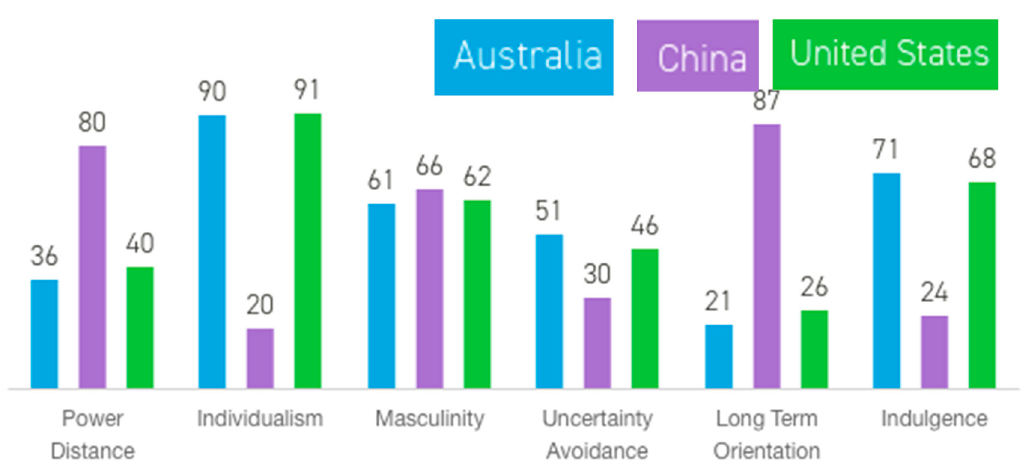
Figure 1. Comparison of cultural dimensions between China and ‘western’ countries, Australia and the United States. Data and graph from ‘Hofstedes Insights’ (www.hofstede-insights.com [5]).